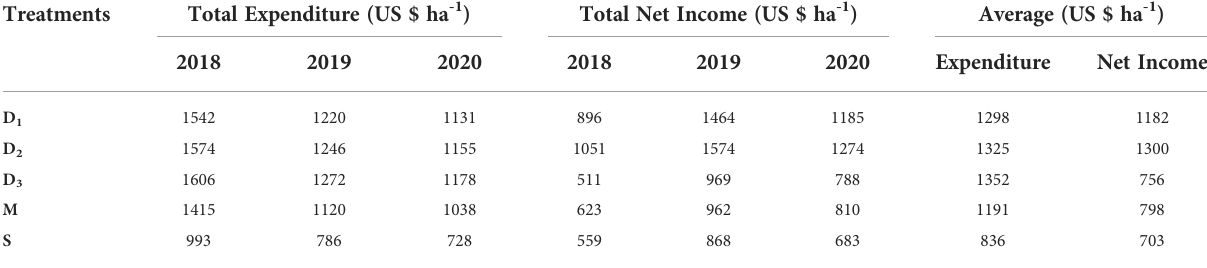
TABLE 7 Total expenditure and total net income of maize and soybean under different maize/soybean strip intercropping treatments and sole cropping of maize and soybean.